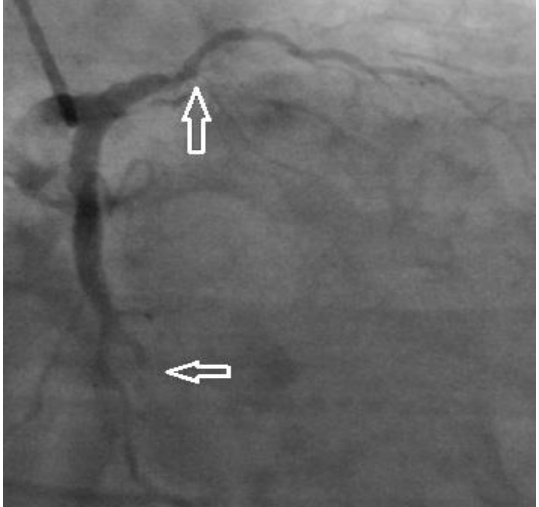
Figure 3A. Left anterior descending artery: cut-off at proximal with retrograde filling via right system; obtuse marginal artery: cut-off at proximal with poor run-off